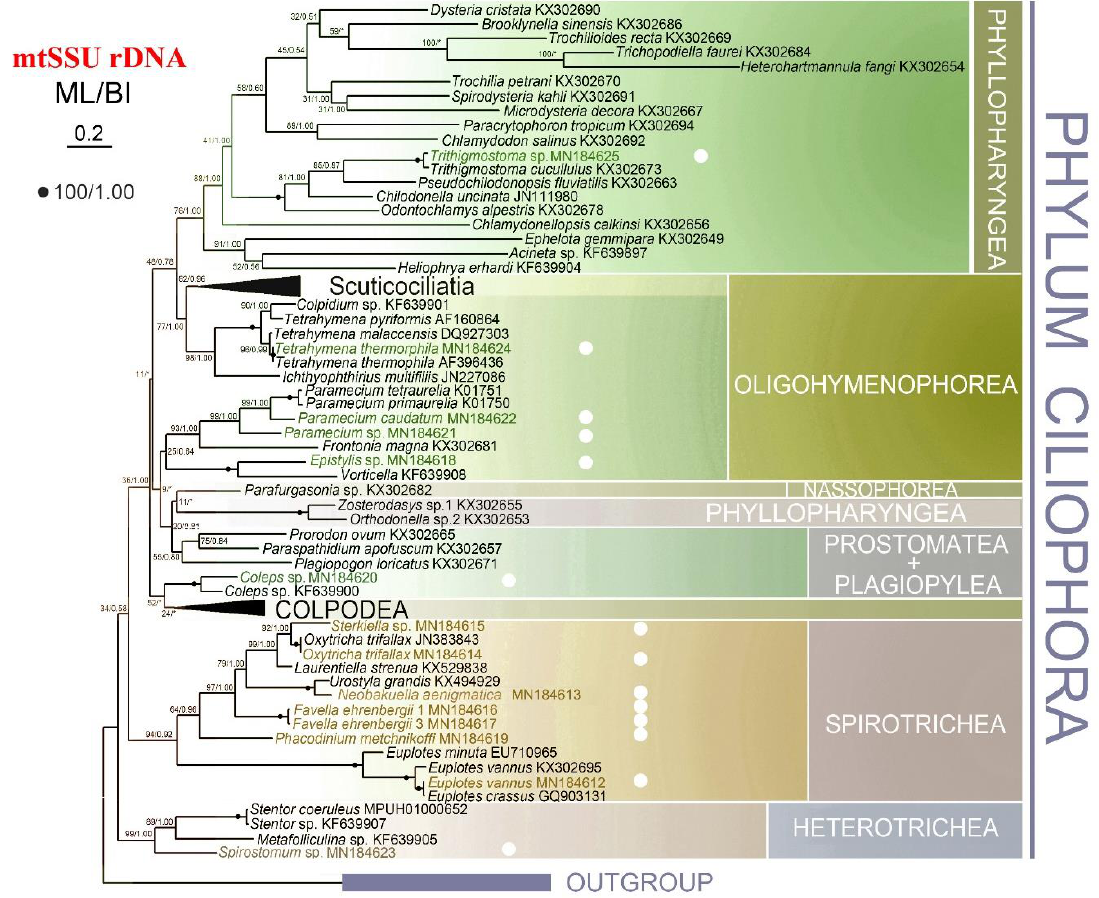
Figure 3. The maximum likelihood (ML) tree based on mtSSU rDNA sequence alignment, highlighting the 13 species studied. Numbers near nodes represent the bootstrap values of ML and the posterior probability values of Bayesian analysis (BI). Dots (.) mean fully supported node (100 / 1.00) while asterisks (*) indicate the disagreement between ML and BI topologies. The scale bar corresponds to two substitutions per 100 nucleotide positions. All branches are drawn to scale. The mtSSU copy number among individuals within species also varies. Possible explanations include that they are undergoing different life stages, having different growth rates or under different nutritional conditions. Unlike mammalian and yeast cells, in which the number of mitochondria is regulated by organelle fusion and fission [67], the mitochondria in ciliates (e.g., Tetrahymena , Paramecium ) do not undergo fusion